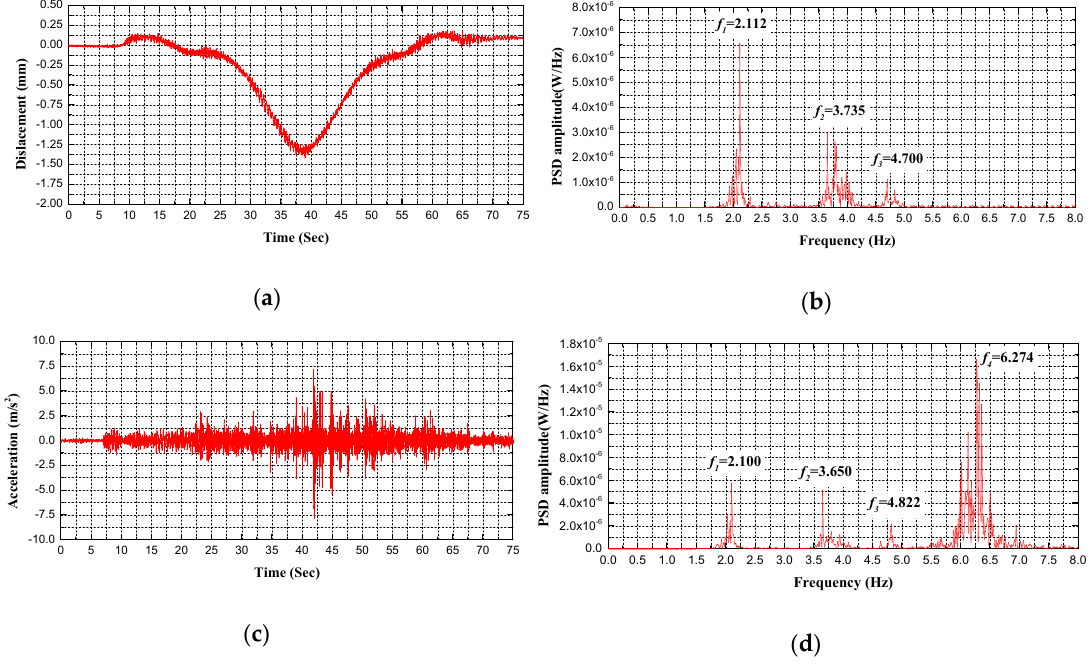
Figure 17. Comparison between measured frequencies for C2 test condition: ( a ) displacement response measured by HVS; ( b ) the PSD of displacement response measured by HVS; ( c ) acceleration signal measured by accelerometer; ( d ) the PSD of acceleration signal measured by accelerometer.